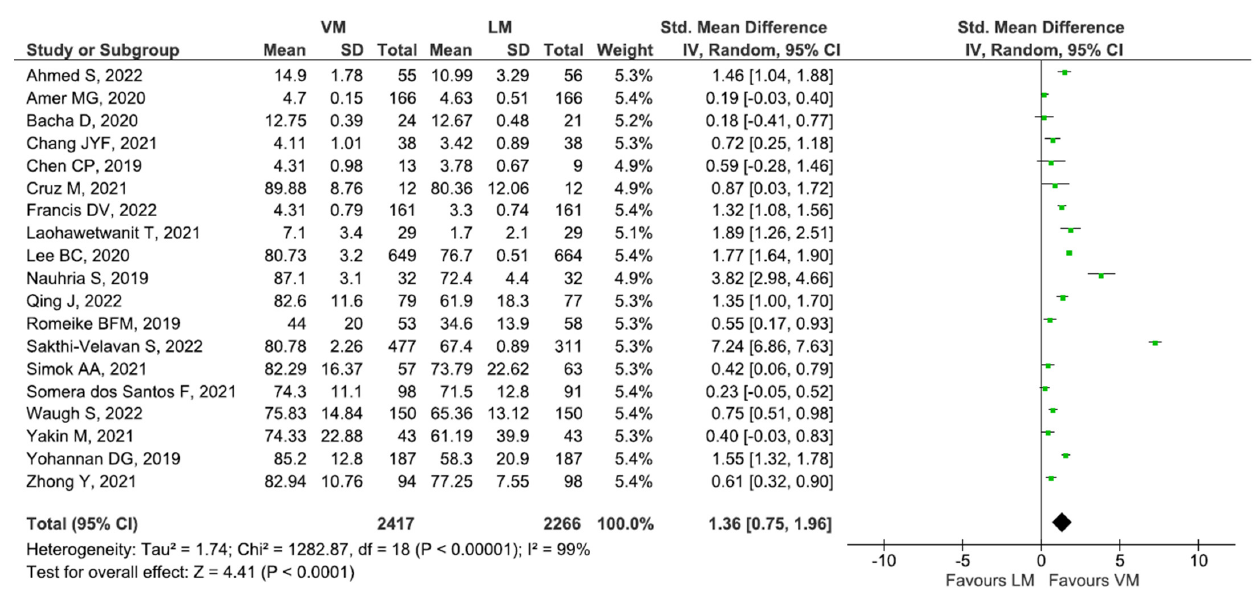
Figure 2. Pooled effect size of 19 studies [20,31–35,37–39,44,45,50,52,57–60,63,64]. Students in the VM group demonstrated significantly higher exam performance than